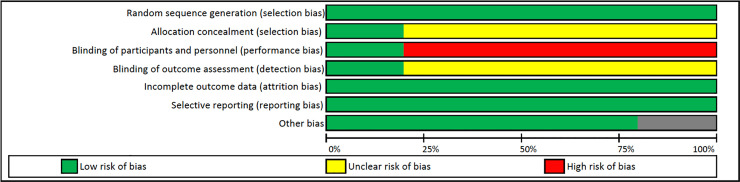
Risk of bias (RCTs).